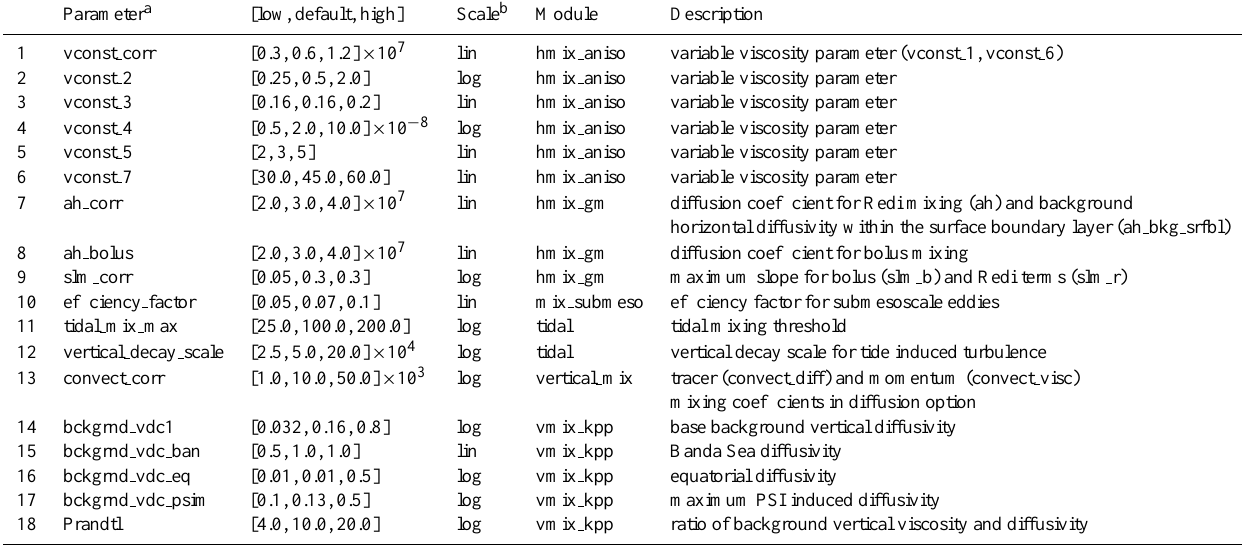
a Individual corr parameters (numbers 1, 7, 9, and 13) are used to represent the correlated pair of parameters given in the description. For example, values drawn for vconst corr are assigned to vconst 1 and vconst 6 . b Linear and logarithmic scales are used for parameter ranges that have ratios of high/low < 5 and high/low ≥ 5 ,